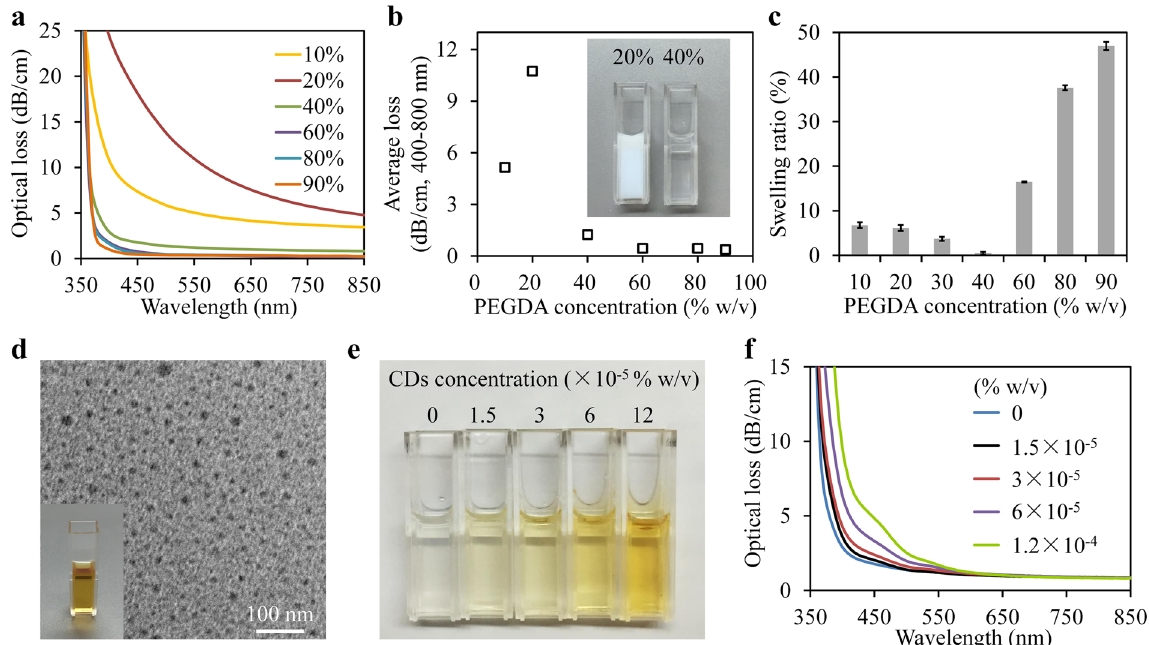
Figure 1. ( a ) Optical loss spectra of PEGDA hydrogels at concentrations from 10% to 90% w/v. ( b ) Dependence of the optical loss of hydrogels on PEGDA concentration, averaged in spectrum range of 400–800 nm. The inset shows the photograph of PEGDA Hydrogels at concentration of 20% and 40%. ( c ) Swelling ratio of the PEGDA hydrogels in deionized water at 25 °C. The swelling ratio was determined from the measured weight ratio between the fully swollen and as-made hydrogel. Error bars, standard deviations (n = 3). ( d ) TEM image of CDs. ( e ) CDs-PEGDA nanocomposites with PEGDA concentration of 40%w/v and CDs concentrations from 0 to 1.2 × 10 − 4 % w/v. ( f ) Optical loss spectra of CDs-PEGDA nanocomposites at various CDs